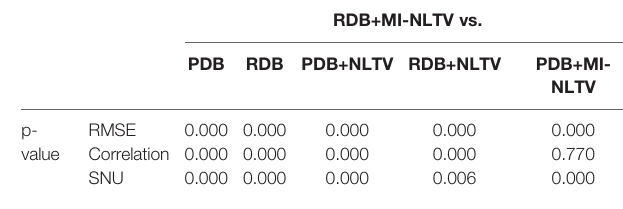
TABLE 4 | Statistical analysis of the three metrics of RDB+MI-NLTV and fi ve approaches using a paired t-test. RDB+MI-NLTV